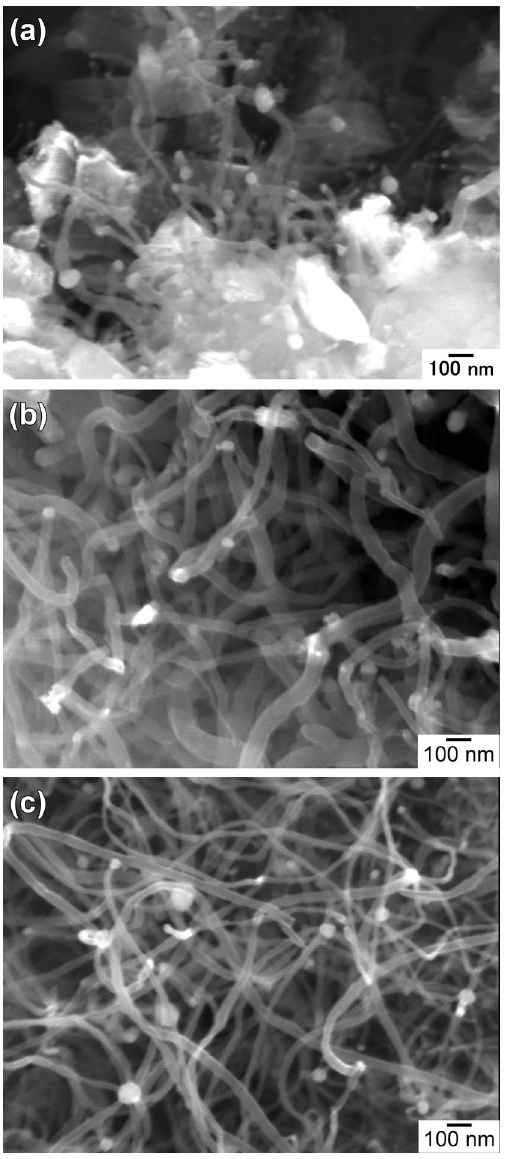
Fig. 6 The effect of reaction time on the number of CNFs pro- duced by each catalyst particle. At a reaction temperature 600 °C, the Ni8Cu2/O-dia. was used as a catalyst. The reaction times are (a) 10 min (b) 30 min and (c) 60 min